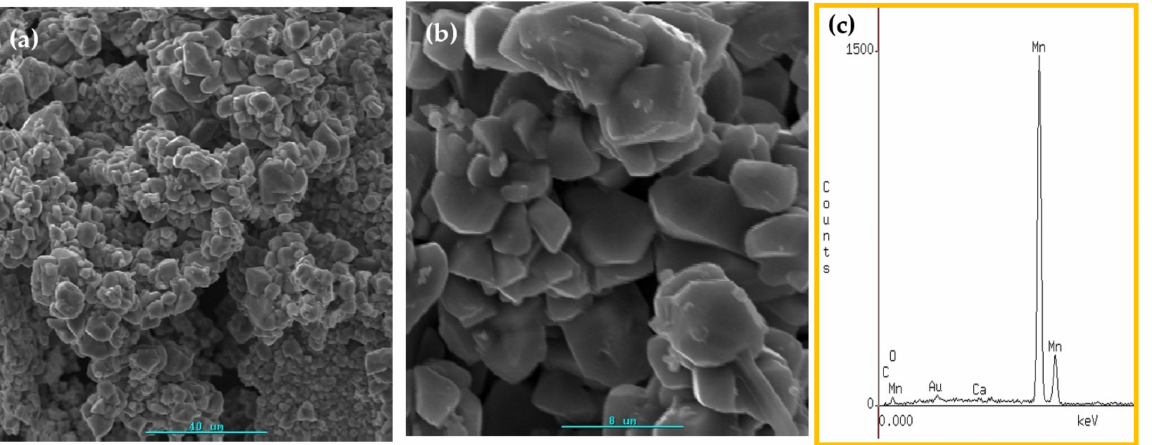
Figure 5. SEM image at two magnification levels ( a , b ) for Mn 2 O 3 and their EDS analysis ( c ).